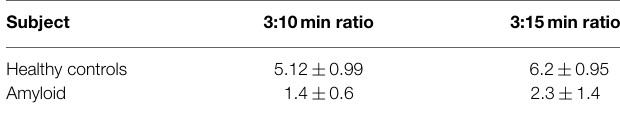
TABLE 3 | SUV ratio values